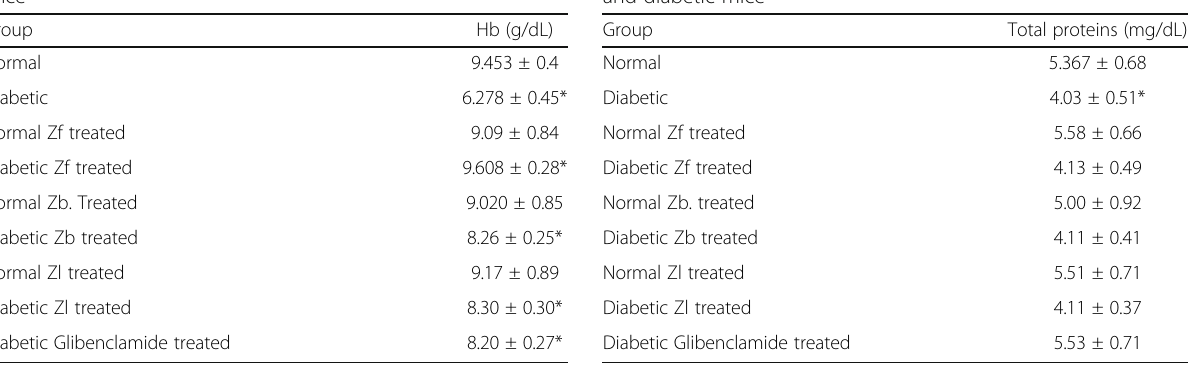
compared with normal control and extract treated. The Diabetic control was compared with diabetic extract treated and